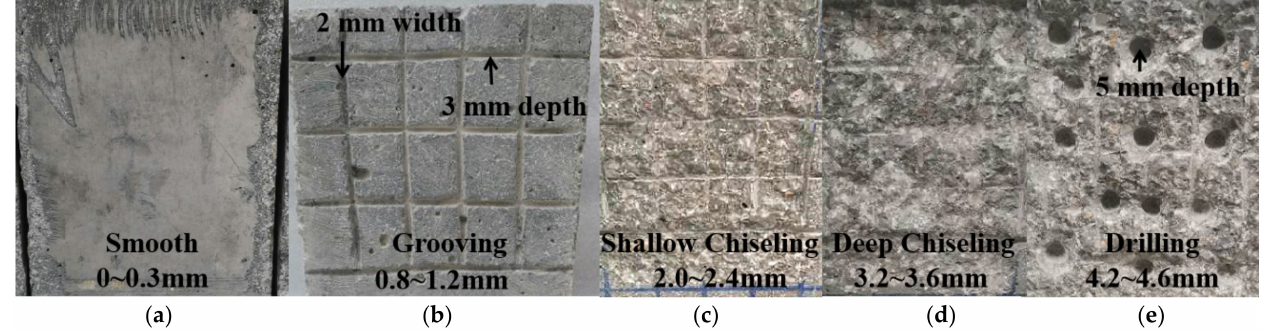
Figure 4. OCS surface roughness in direct shear test. ( a ) R0 (type I); ( b ) R1 (type II); ( c ) R2 (type III); ( d ) R3 (type III); ( e ) R4 (type